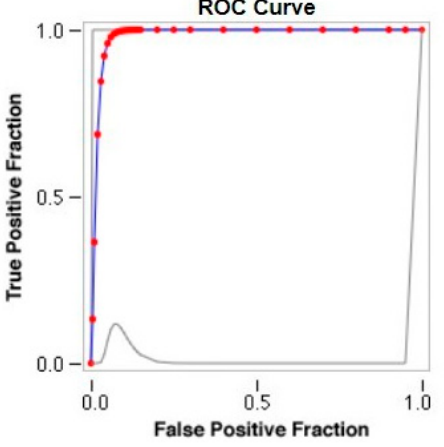
Figure 4. ROC curve of PAPVR ratio values in our population.